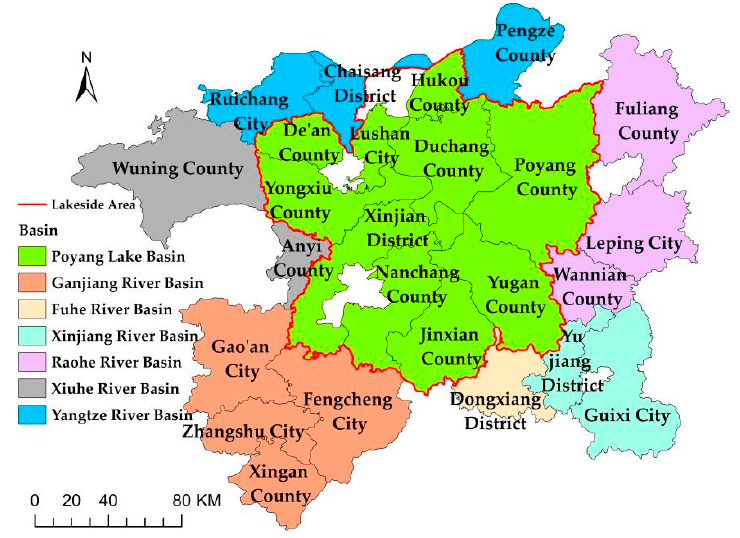
Figure 1. The regional division of the Poyang Lake area.